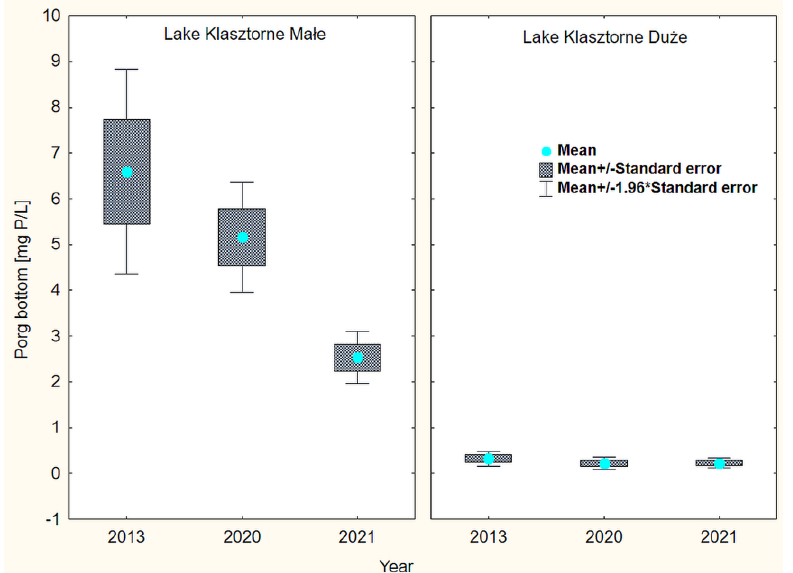
Figure 11. Average annual values of organic phosphorus (P org .) in the bottom water of Klasztorne lakes in selected research years.